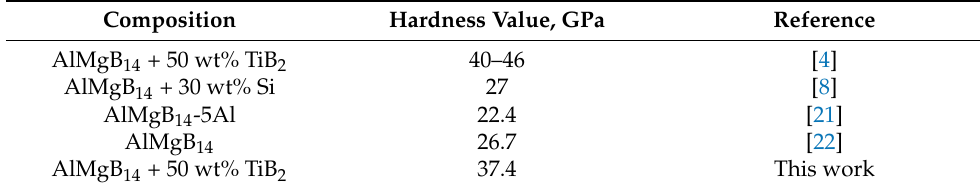
Table 3. Comparison of hardness values of AlMgB 14 -based